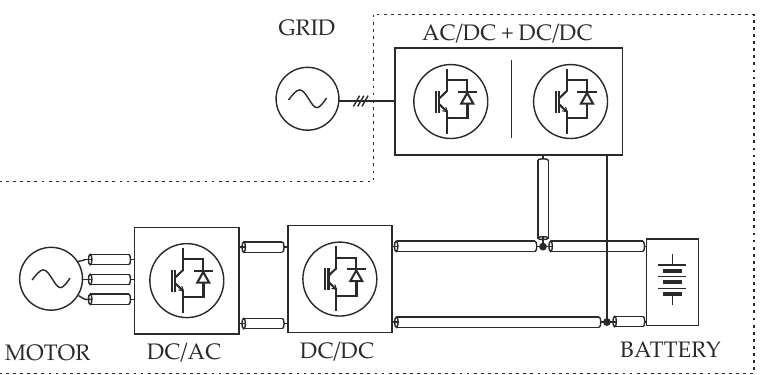
Figure 1. Typical EV power circuit including the propulsion system, the onboard charger, and the power